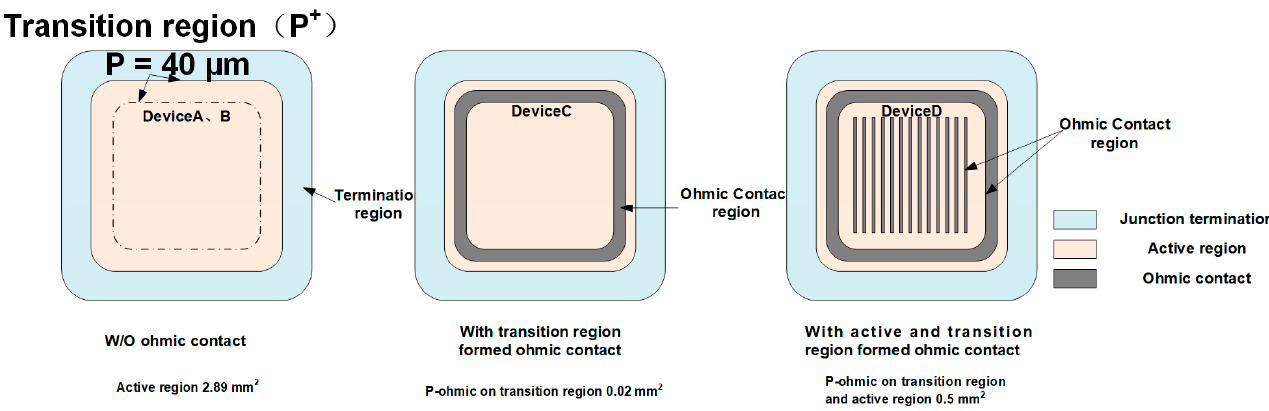
Figure 5. Three layout types of Device A, B, C, D. Device A and B are JBS, Device C and D are MPS.